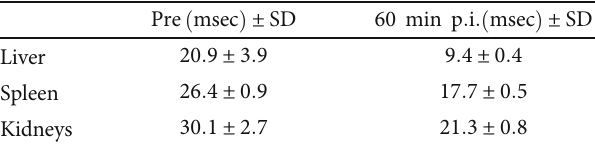
Table 2: Prescan and 60min